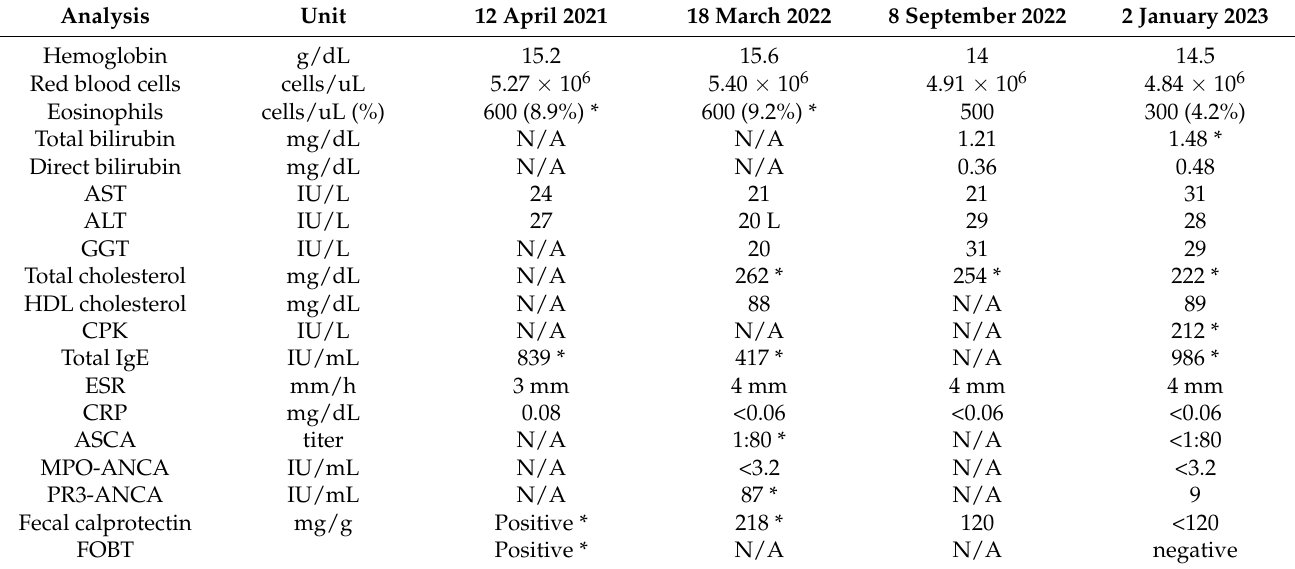
Table 1. Results of laboratory analysis performed in April 2021, before initiation of treatment with dupilumab; in March 2022, before switching to upadacitinib; and in September 2022 and January 2023, after 4 and 8 months of therapy with upadacitinib, respectively. Values outside normal laboratory reference ranges are marked with